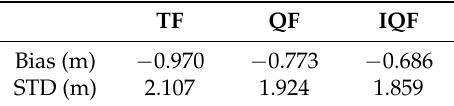
Table 4. Overall bathymetry accuracy (bias and STD) using the simulated